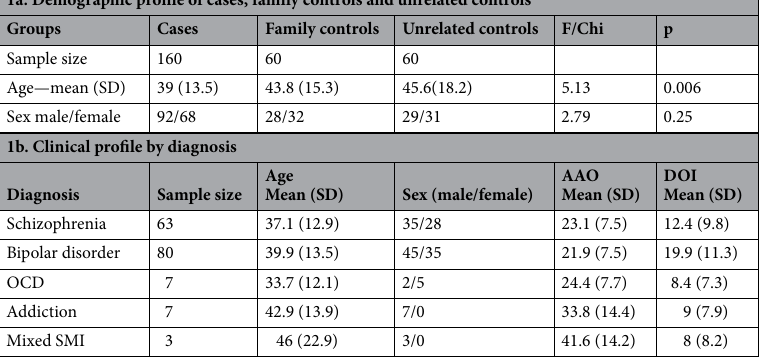
Table 1. Demographic and clinical profile of the sample. AAO age at onset, DOI duration of illness, SD standard